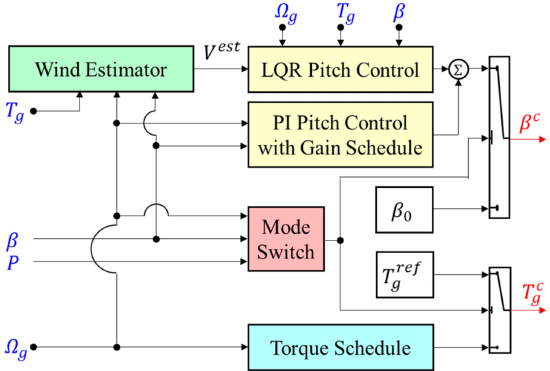
Figure 8. Block diagram of the LQR-PI hybrid control